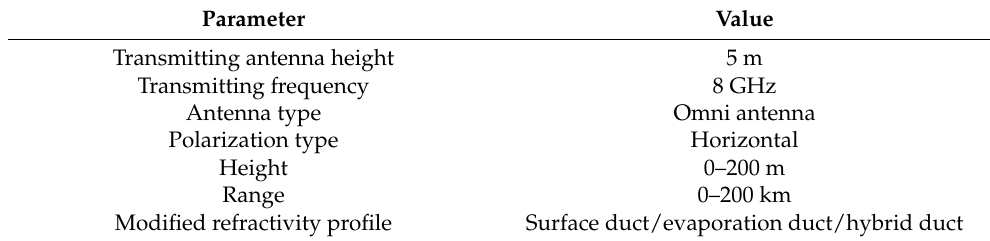
Table 4. Parameters for the PE